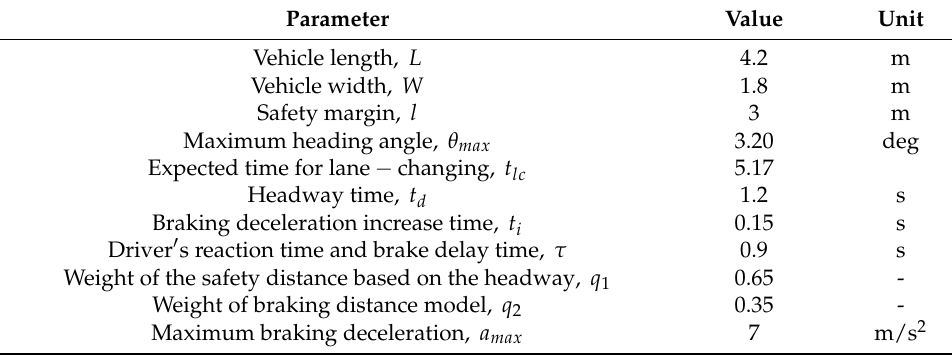
eters in the lane-changing safety distance model have been determined shown in Table 2. Table 2. Parameters of lane-changing safety distance model. Table 2. Parameters of lane-changing safety distance model. Parameter